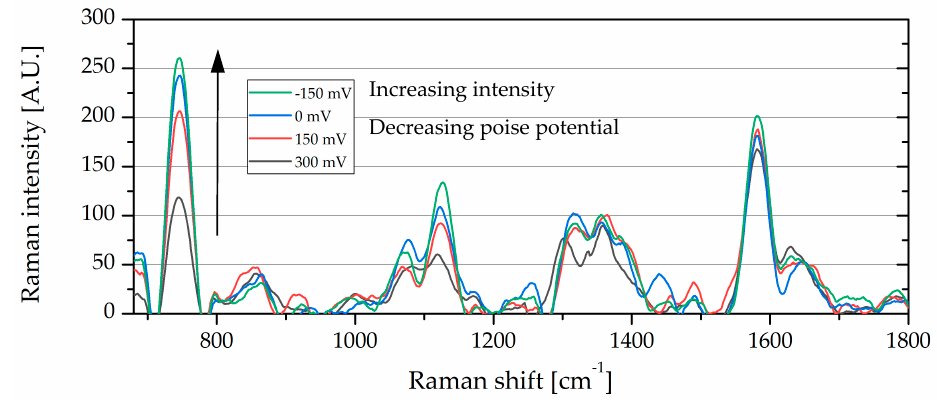
Figure 6. Processed Raman spectra showing the changes in the strong peak at 745 cm − 1 , which is related to the cytochrome oxidation state.